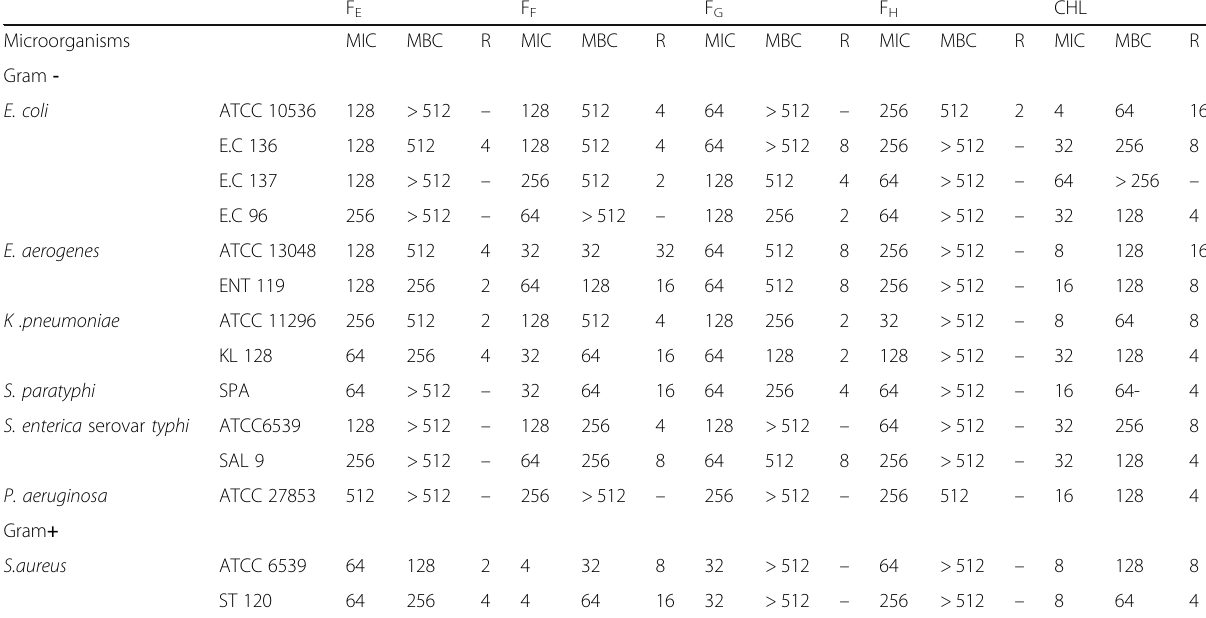
Table 4 Minimum Inhibitory Concentrations (MIC), Minimum Bactericidal Concentrations (MBC) and MBC/MIC ratios (R) of n- butanol fraction and sub-fractions from the methanol extract of E. chlorantha stem barks ( μ